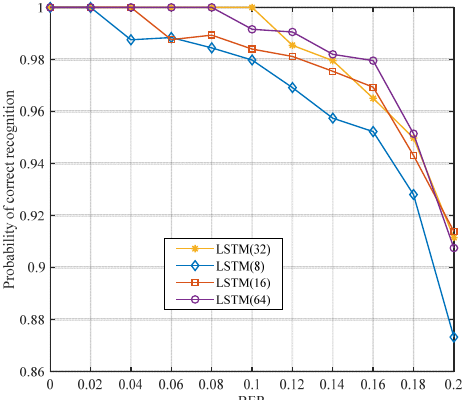
Figure 8. The effect of the number of cells of LSTM on the performance of the algorithm.